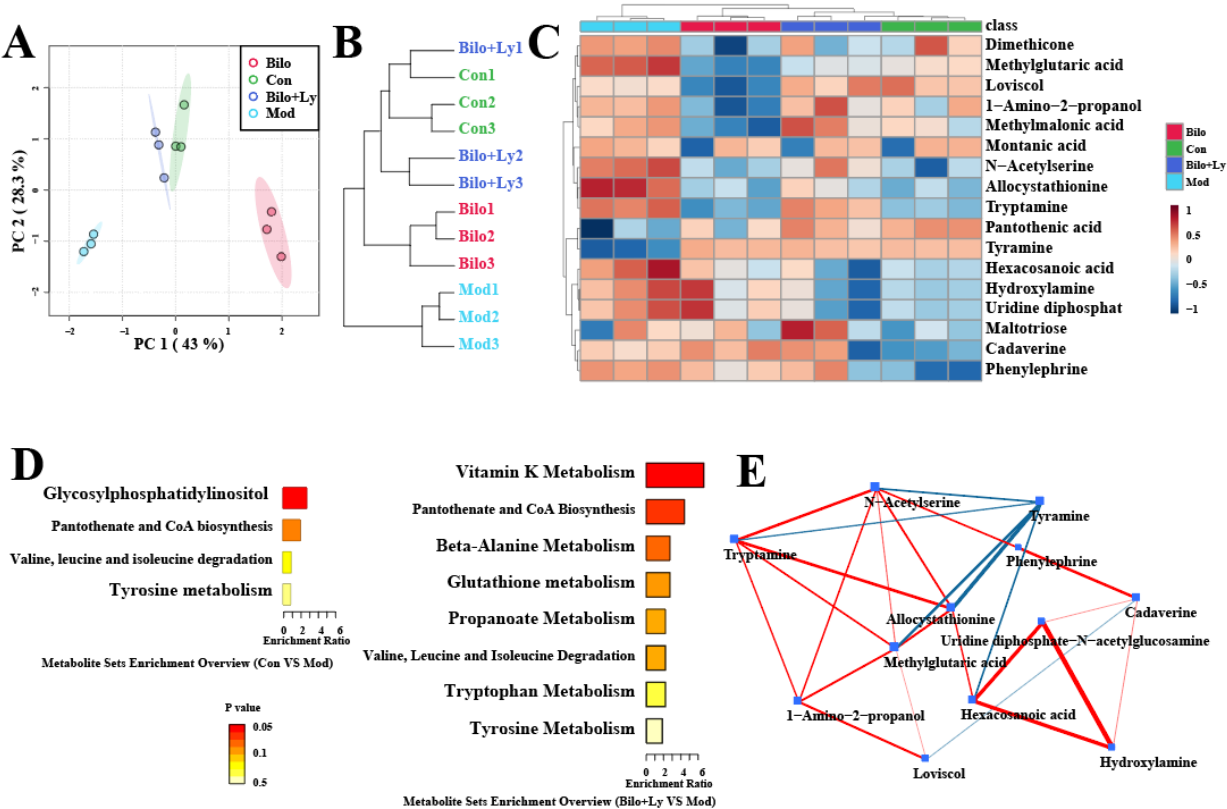
Figure 6. The effect of lycopene on renal metabolism in mice. Metabolite PCA plot ( A ). Metabolite cluster dendrogram ( B ). Differential metabolite heatmap ( C ). Differential metabolic pathway enrichment map ( D ). Differential metabolite network diagram ( E ).